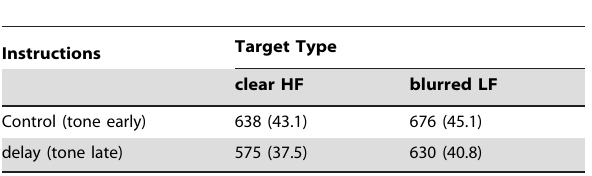
Table 3. Experiment